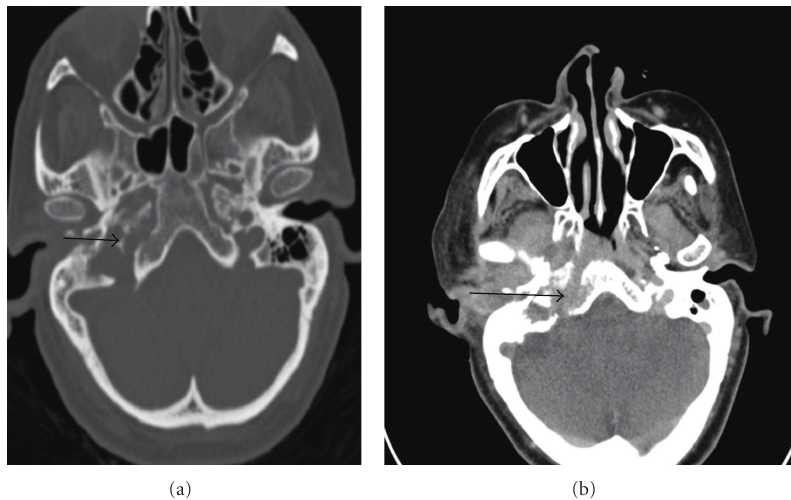
Figure 1: Right inner ear and temporal bone computed tomography scan on first admission (a) and on readmission (b) showing opacification of the right external auditory canal, right tympanic, and epitympanic spaces, as well as the right mastoid antrum. There is also bony destruction of the anterior wall of the right external auditory canal, scutum and wall of the right carotid canal, foramen lacerum, and semicircular canals. The arrows show the extent of tumor spread into the middle ear.